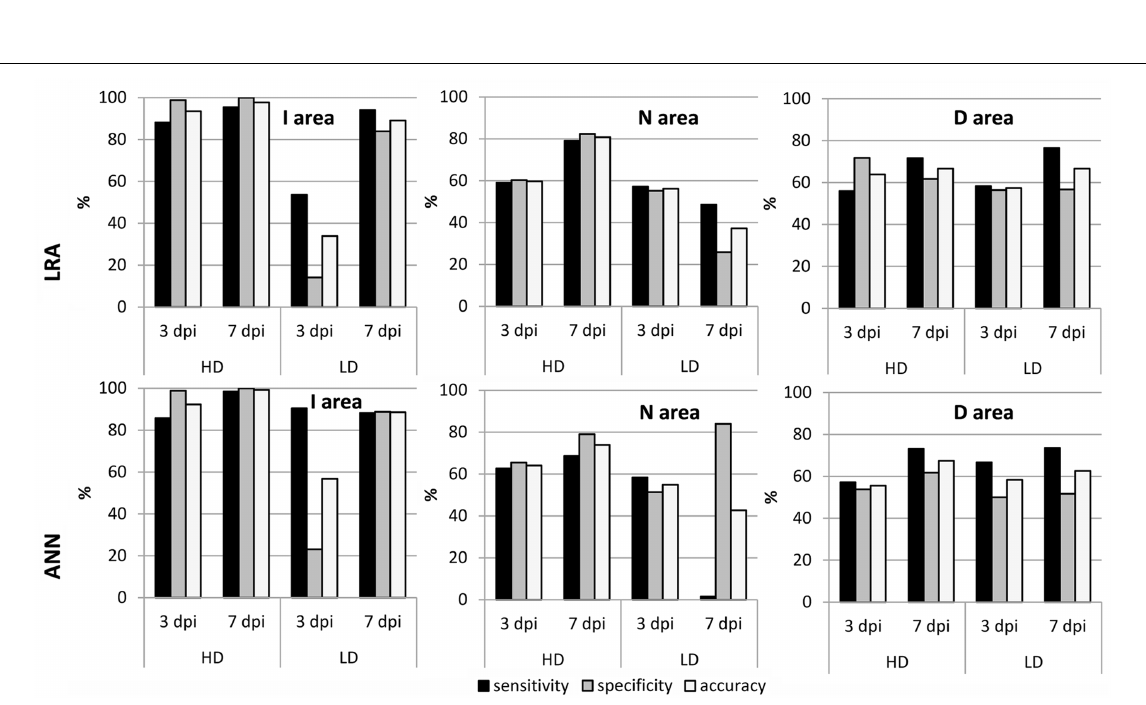
Frontiers in Plant Science |